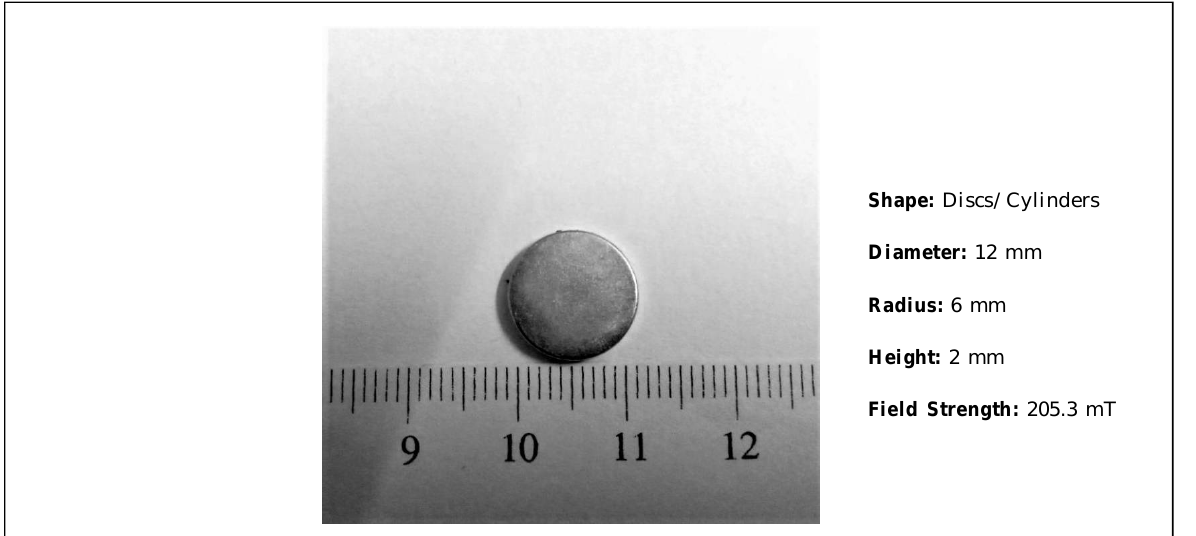
Shape: Discs/Cylinders Diameter: 12 mm Radius: 6 mm Height: 2 mm Field Strength: 205.3